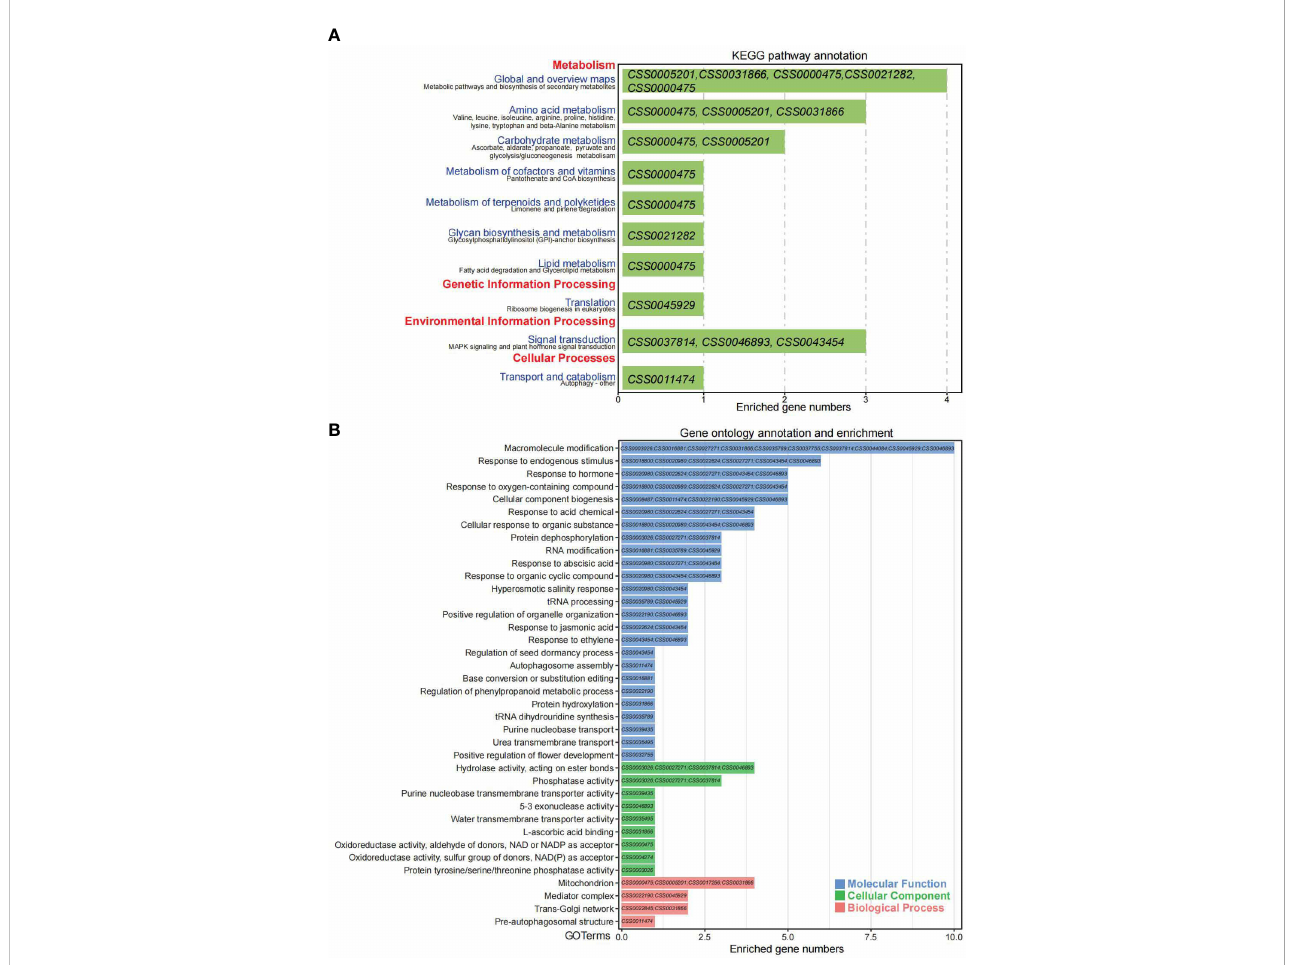
FIGURE 6 The KEGG and GO annotation and enrichment analyses of overlapped 53 genes under positive natural selection were identi fi ed both by single locus and genomic blocks. (A) The KEGG pathway annotation and enrichment for 53 overlapped genes with strong selection signals by VCFtools and XP-CLR software. The pathway terms of KEGG_A_class and KEGG_B_class were indicated with red and purple colors on Y-axis, respectively. The gene IDs enriched for each pathway were shown in the green bars. The X-axis indicates enriched gene numbers. (B) The GO enrichment analysis for 53 overlapped genes with strong selection signals by VCFtools and XP-CLR software. The GO terms with blue, green and red colors indicate molecular function, cellular component and biological process, respectively. The gene IDs enriched for each GO term were shown in the bars. The X-axis indicates enriched gene